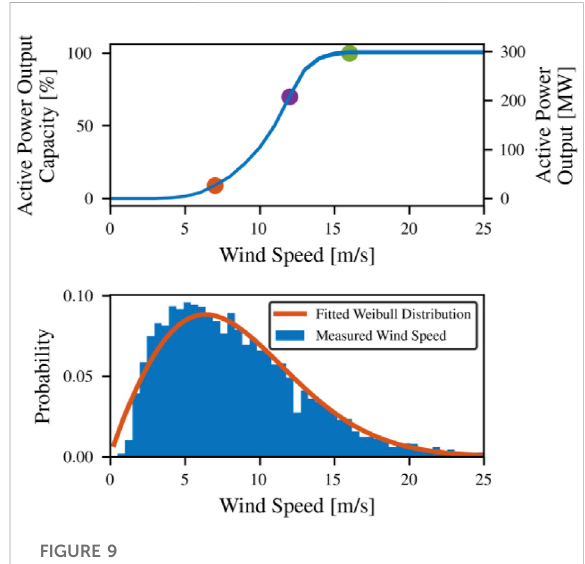
FIGURE 9 (A) Wind Power curveusedinstudy (B) Cumulative frequency graph with the average of four wind sites recorded over the calendar year of 2015 with a fi tted Weibull distribution.